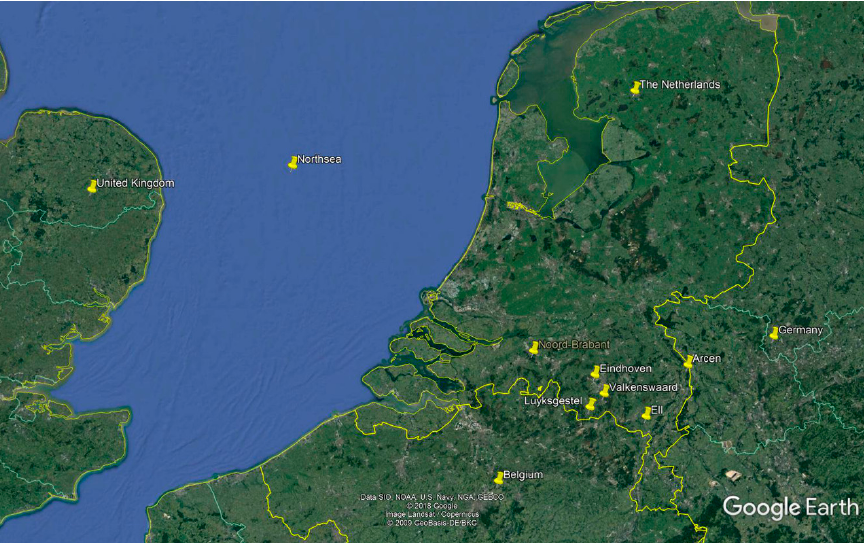
Figure 1. Map of the study area, indicating the municipalities with severe hail damage, and